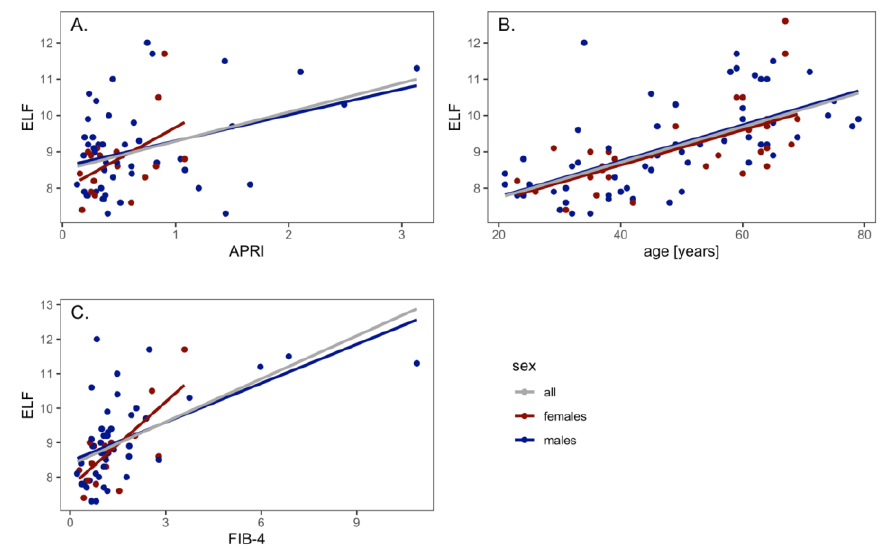
Figure 2. Correlation of ELF test with APRI ( A ), age ( B ) and FIB-4 ( C ).